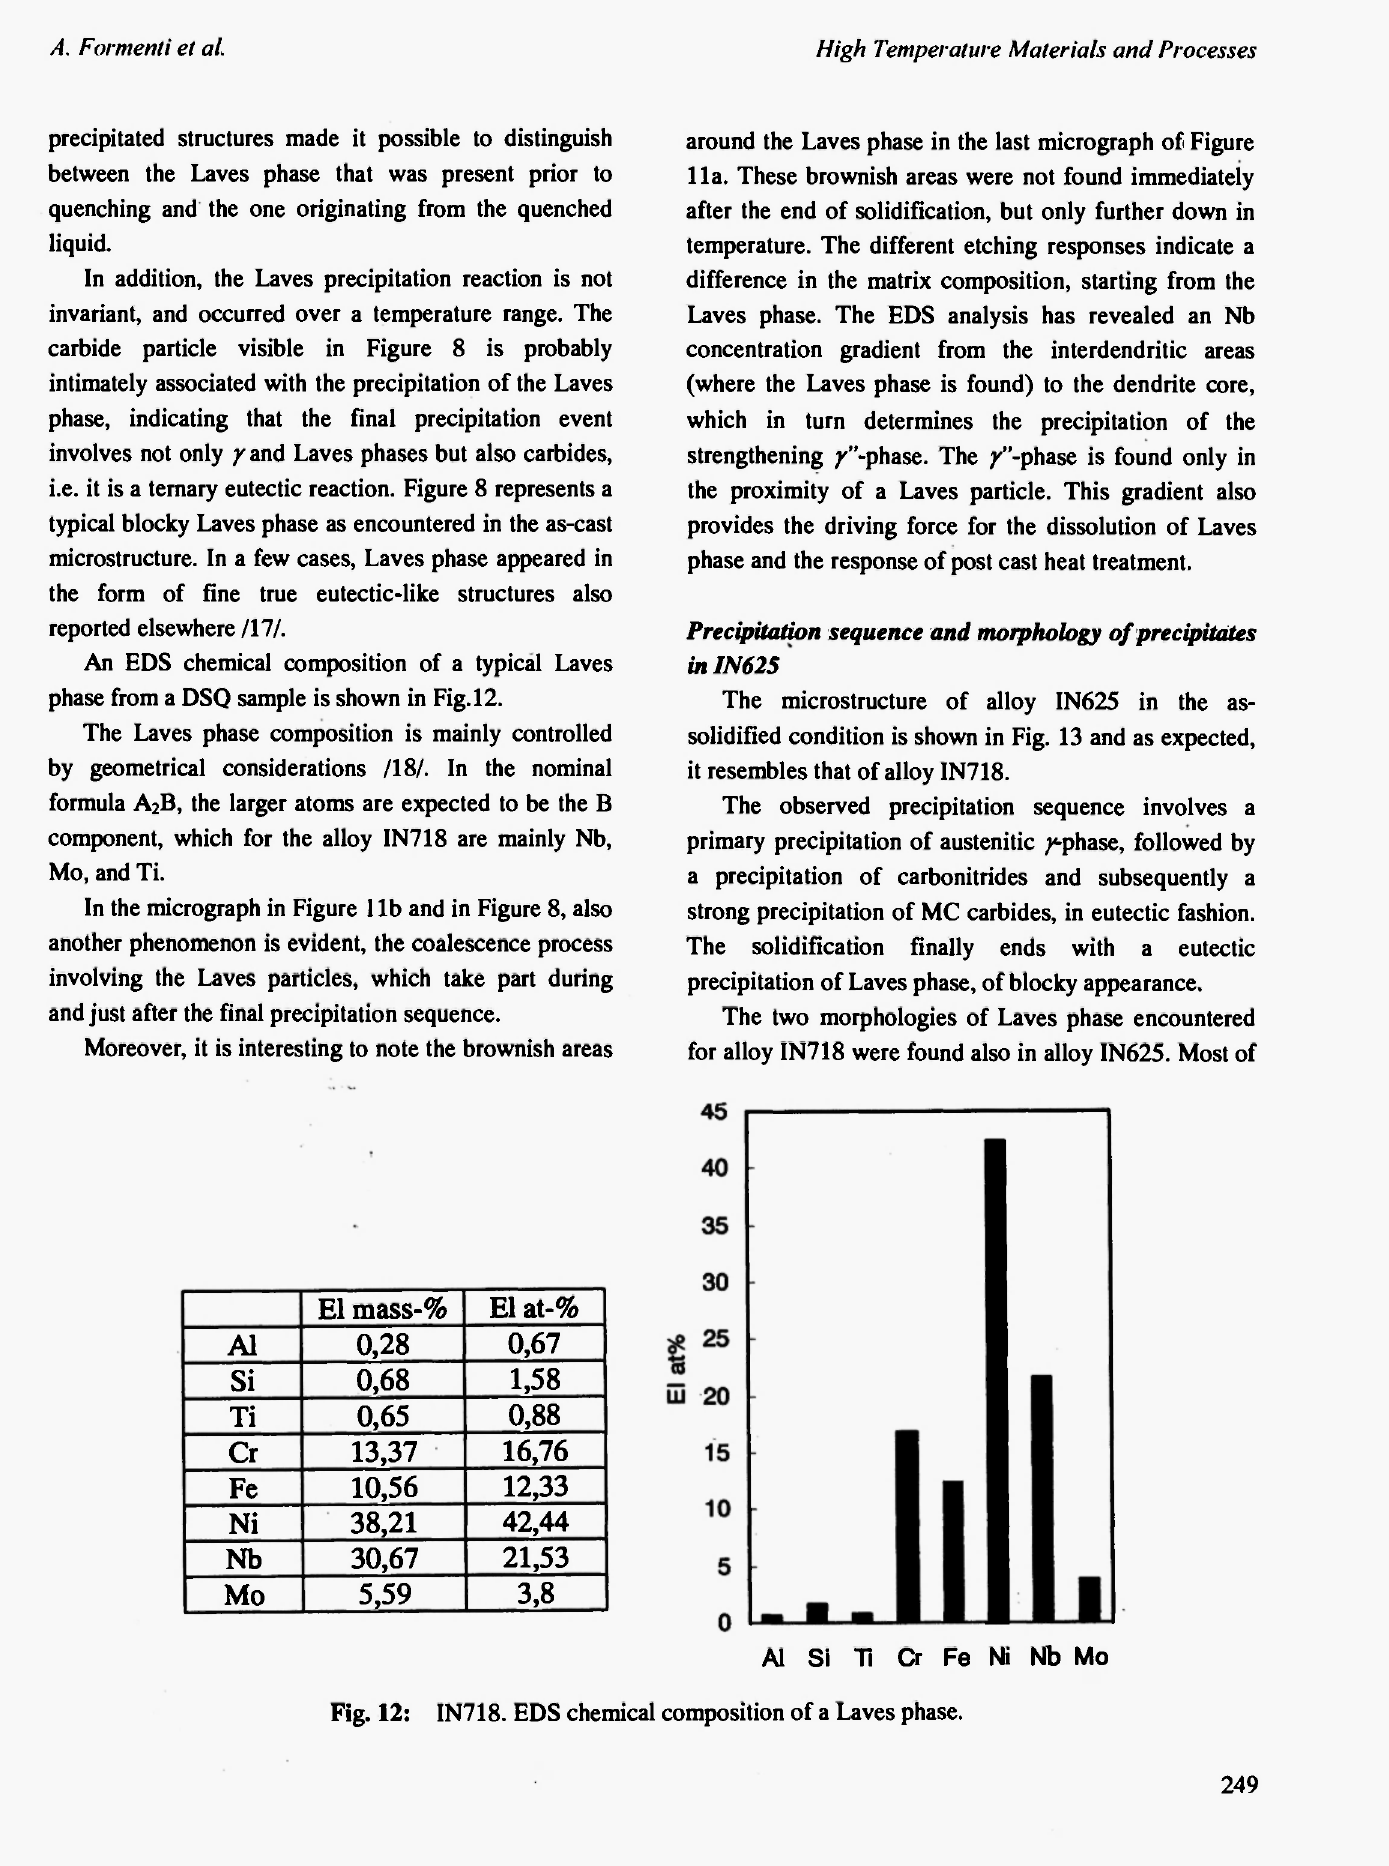
IN718. EDS chemical composition of a Laves